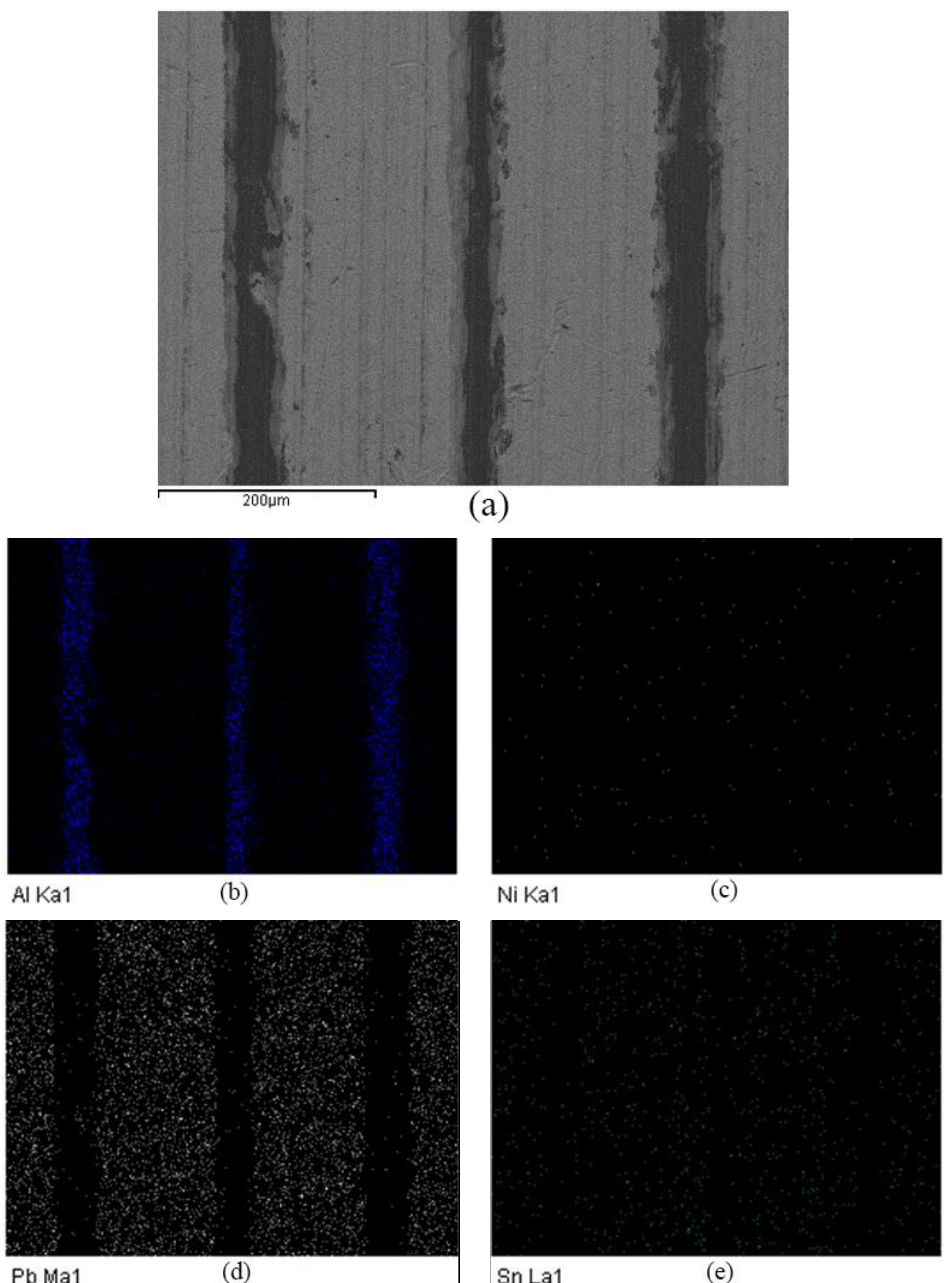
Figure 7. Original surface morphology and element distribution of the sliding bearing. ( a ) Surface morphology, ( b ) Al distribution, ( c ) Ni distribution, ( d ) Pb distribution, ( e ) and Sn distribution.